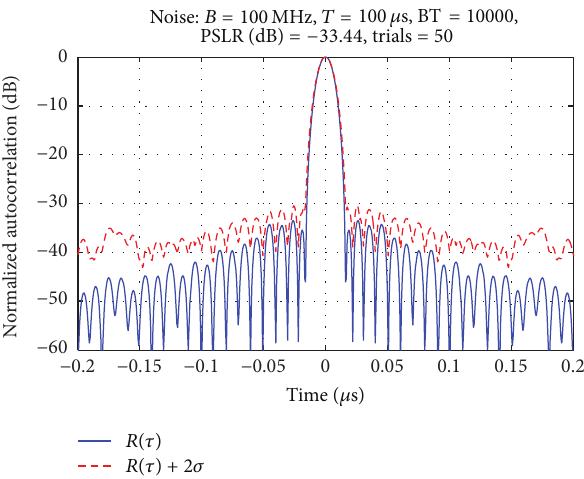
Figure 2: Mean normalized autocorrelation (obtained averaging 50 different autocorrelations). Dashed line: fluctuation at 2 𝜎 ( 𝜎 denotes the standard deviation). Compression ratio BT = 10000, and the ZMNL is a hard limiter.